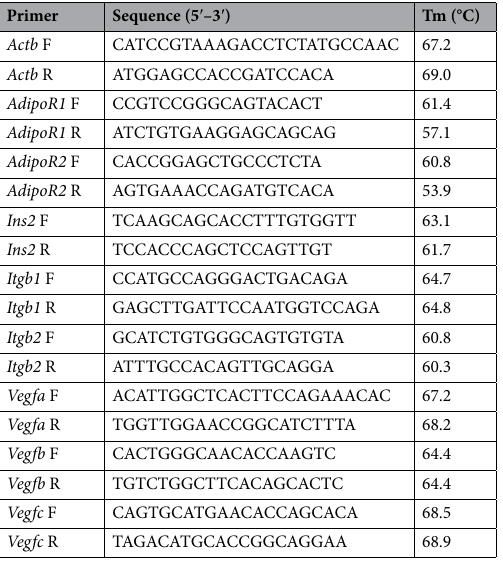
Table 1. Primers used for qRT-PCR analysis. Tm melting temperature, F forward, R